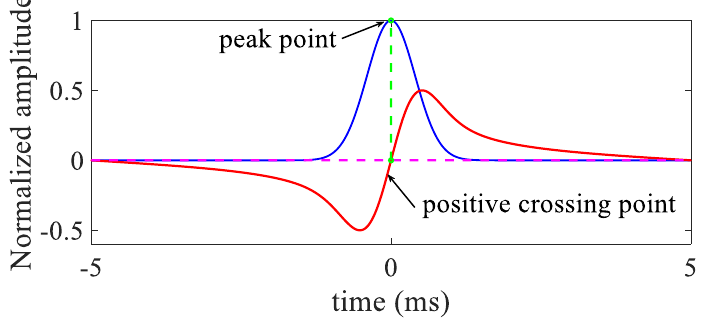
Figure 11. Peaks detection logic. The processing flow of the adaptive peak detection algorithm given in this paper is shown in Figure 11, which mainly involves bandpass filtering, amplitude normalization, square transform, triangular filtering, envelope extraction and Hilbert transform. For the BPSK demodulation and encoding signal detection shown in Figure 12, the above processing can be realized according to Equations (6) and